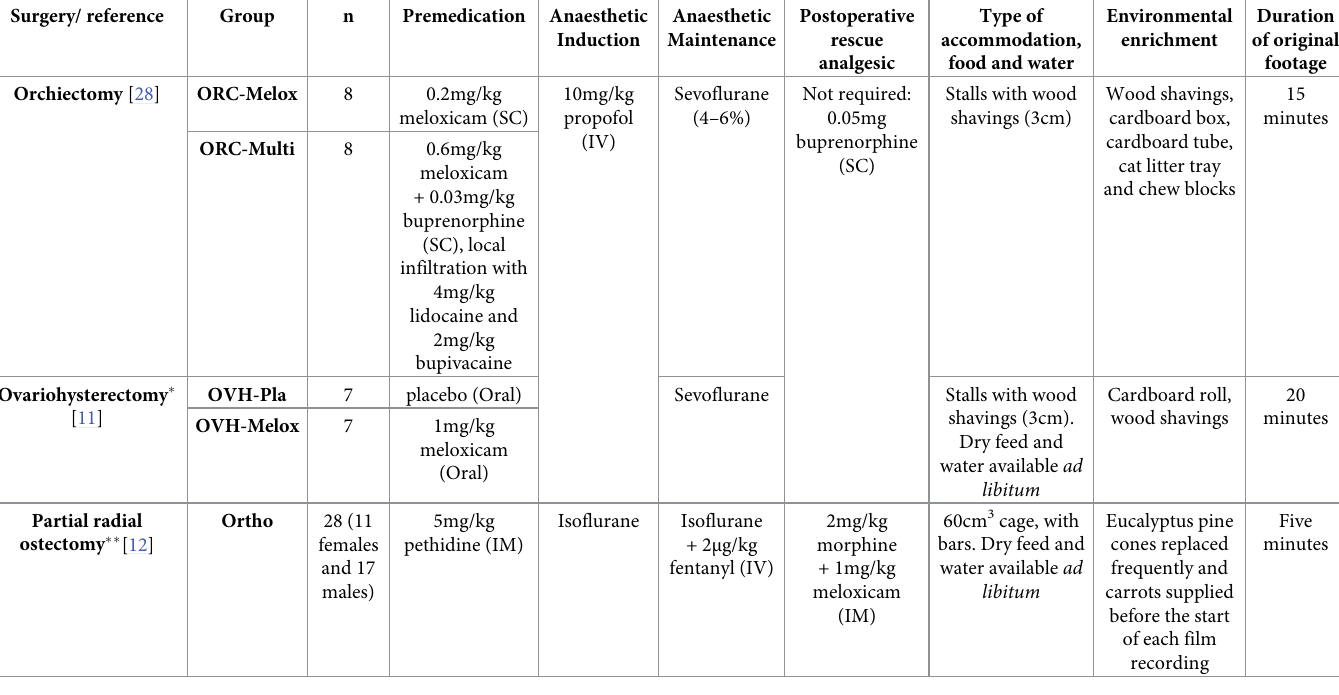
Table 1. Description and summary of the five experimental groups based on the three previous studies. Surgery/ reference